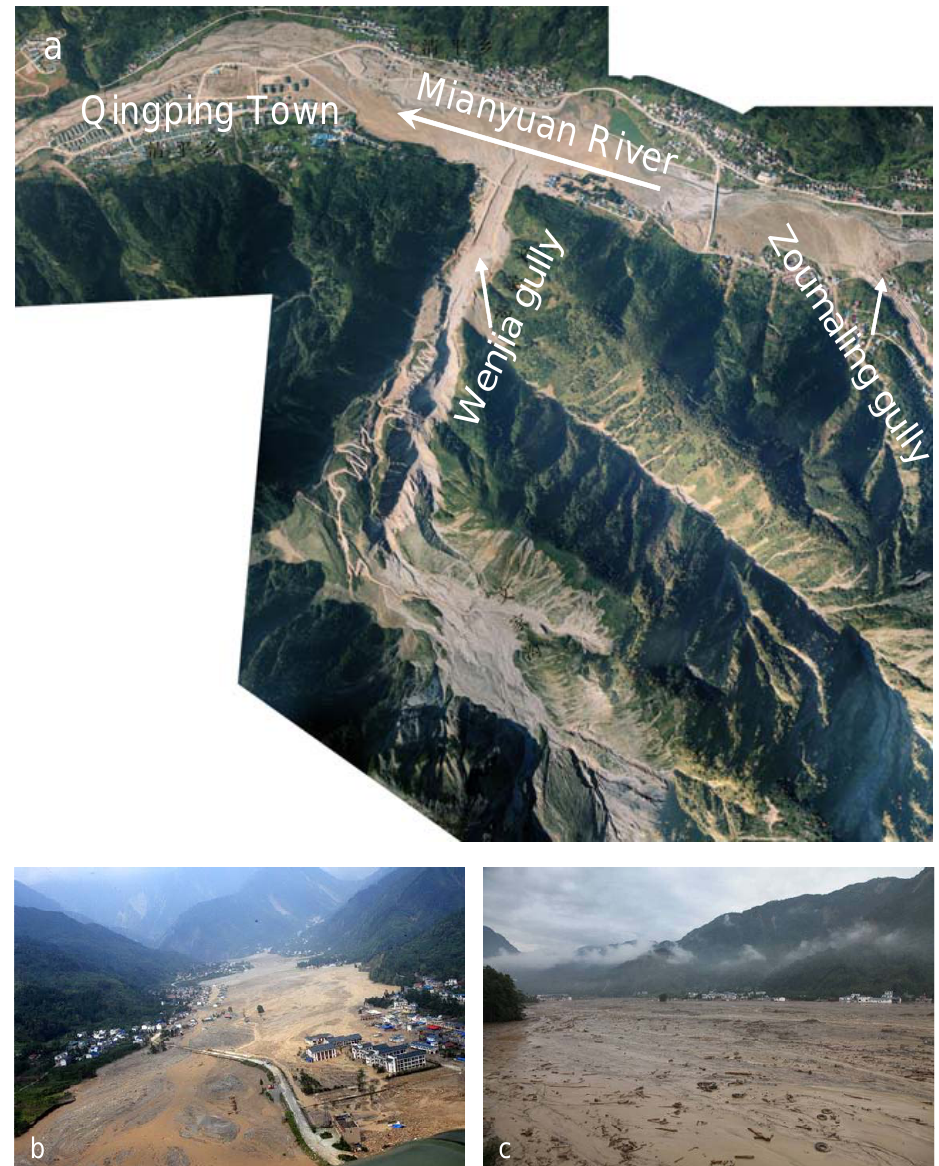
Fig. 10. Qingping Town buried by the 8.13 debris flows ( a : aerial photograph taken after the 8.13 debris flows; b : photo of the buried Qingping Town taken from downstream to upstream of the Mianyuan River after the 8.13 debris flows; c : photo of the buried Qingping Town taken from upstream to downstream of the Mianyuan River after the 8.13 debris flows.